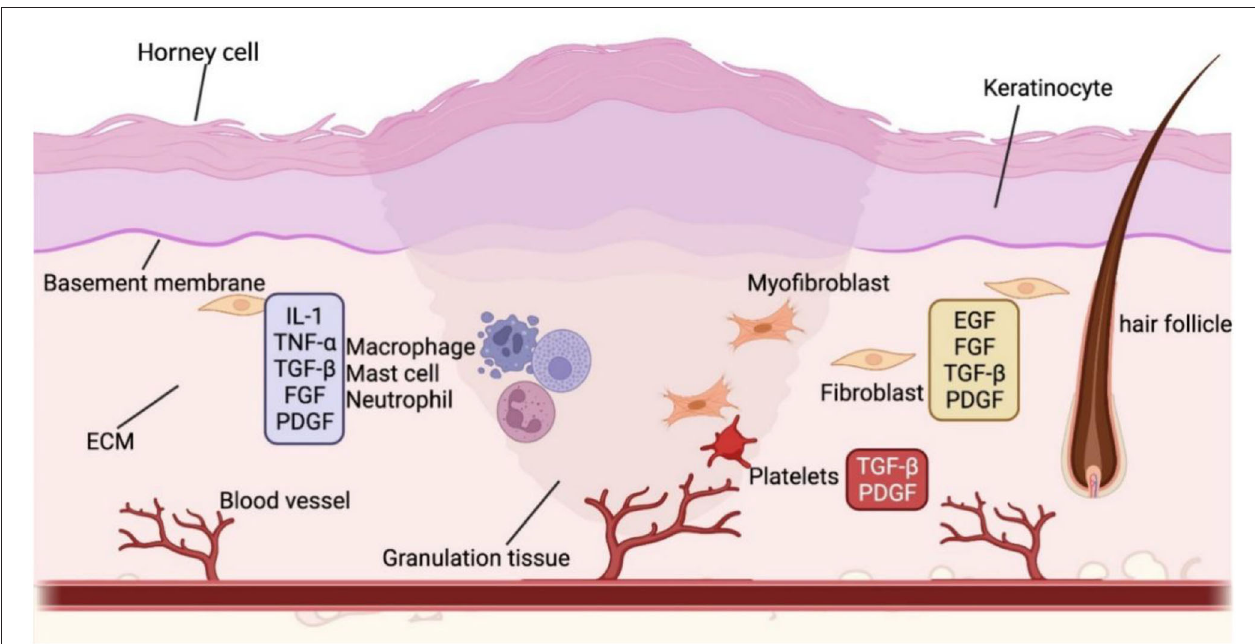
FIGURE 2 | The wound healing process. The various colors in the diagram frames indicate that the molecules in the frame are released by different cells. For example, blue represents inflammatory cells, yellow stands for fibroblasts, and red refers to platelets. Wound healing is a complex biological process. In the wound bed, inflammatory cells proliferate and recruit other required cells in the commence. As the inflammation subsides, endothelial cells in the wound bed increase, followed by the production of granulation tissue and wound site re-epithelialization. The wound contracts and ultimately forms a scar when the extracellular matrix is reconstructed with diminished cell counts. BMP, bone morphogenetic protein; DC, dermal condensate; DP, dermal papilla; Eda, ectodysplasin A; DKK, Dickkopf; EGF, epidermal growth factor; FGF, fibroblast growth factor; HF, hair follicle; HFSC, hair follicle stem cell; IL, interleukin; SHH, sonic hedgehog; PDGF, platelet-derived growth factor; TGF- β , transforming growth factor β ; VEGF, vascular endothelial growth factor; Wnt,